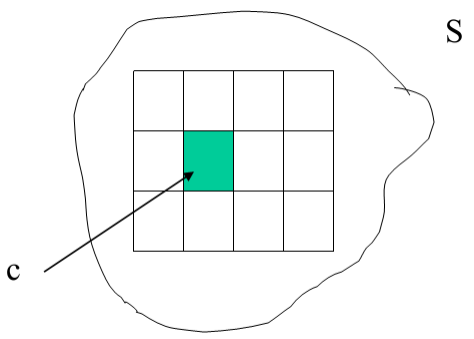
Figure 3. Definition of the 2-D space for image presentation.